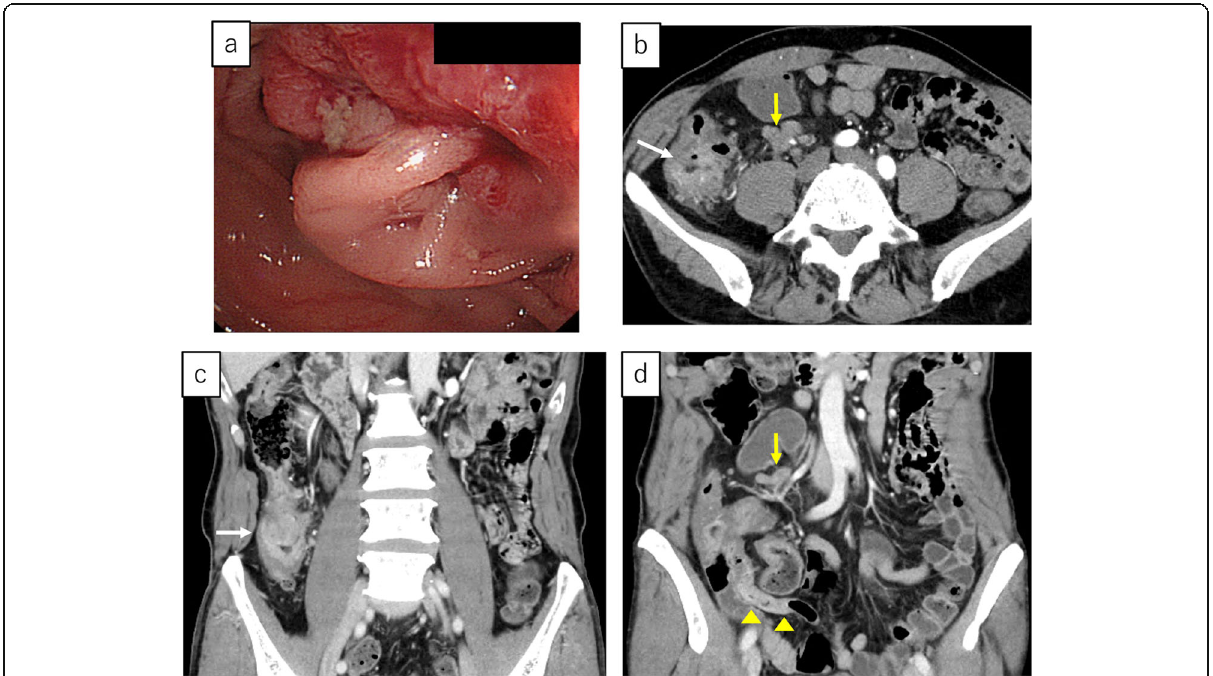
Fig. 1 a Colonoscopy image showing a type-2 tumor in the ascending colon. b – d Enhanced abdominal computed tomography images showing focal thickening in the ascending colon (white arrow) and middle of the appendix (yellow arrowheads) and swelling of the lymph nodes around the ileocolic artery (yellow arrow)